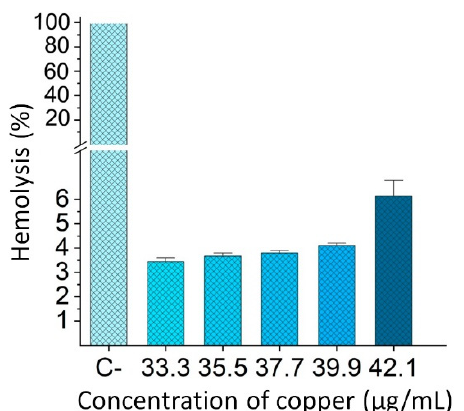
Figure 9. Percentage of hemolysis of red blood cells (RBC) incubated in different concentrations of CuONPs. n = 3. Values are the mean ± SD.